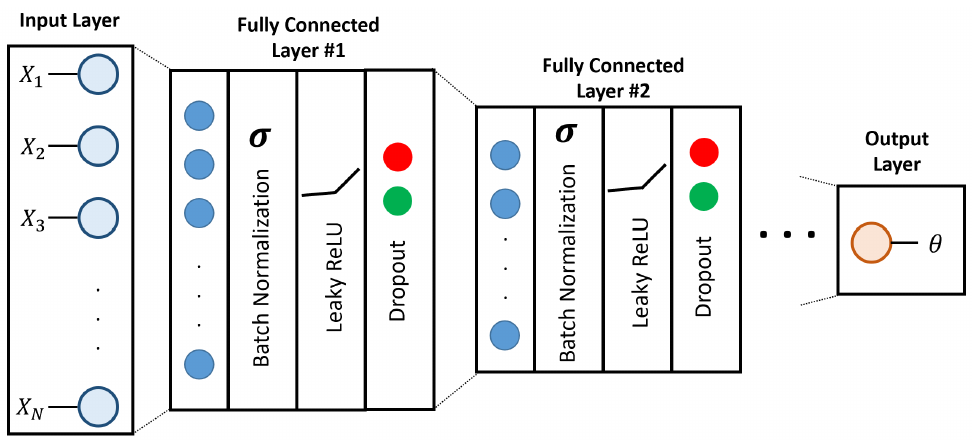
Figure 11. The architecture of the contact angle estimation DL model. The input is a vector of size 74 that corresponds to the pixel coordinates of the markers on the elastomer material. The model consists of N dense fully connected hidden layers, each followed by batch normalization, dropout and a leakyReLU activation function. The output layer represents the estimated contact angle.